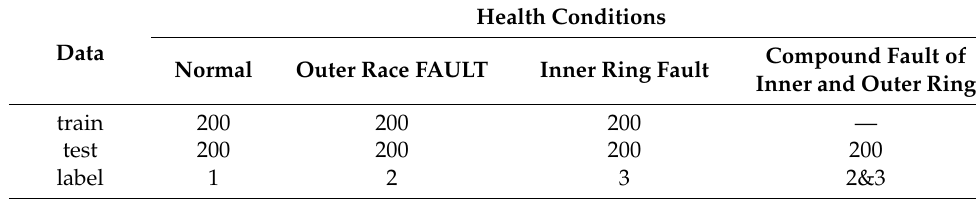
Table 4. Bearing dataset description.